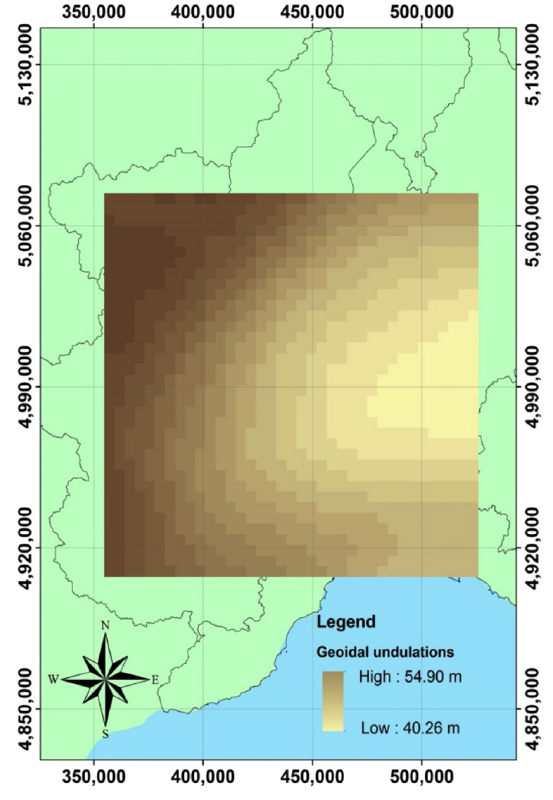
Figure 2. EGM2008 geoid undulations (2.5’ × 2.5’) in the considered area (horizontal coordinates are in